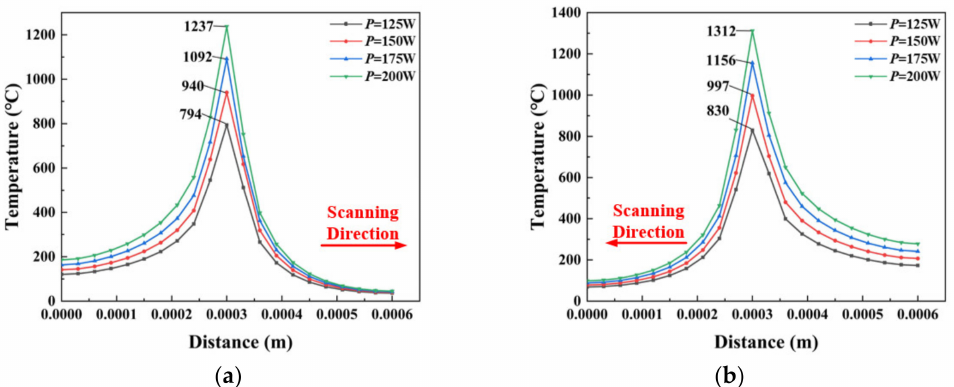
Figure 6. The temperature distribution of the laser heat source along the scanning direction under different powers at scan centers. ( a ) temperature distribution at T = 0.0015 s ( b ) temperature distribution at T = 0.0045